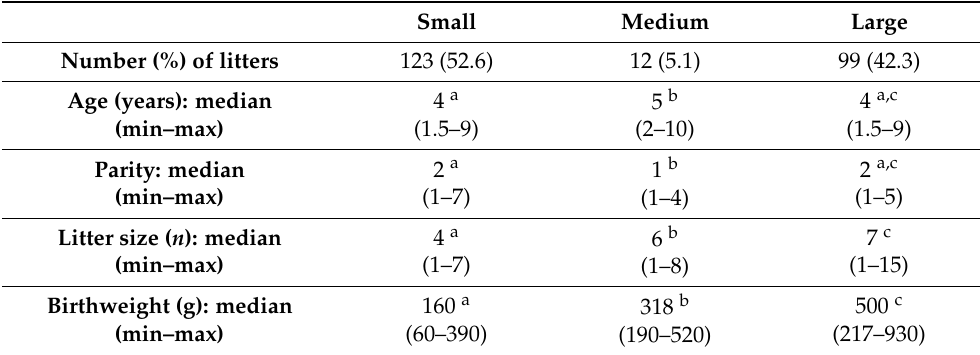
Table 2. Data about age, parity, litter size and birthweight in the 234 litters grouped according to BBS (small, medium, large). Data are expressed as median